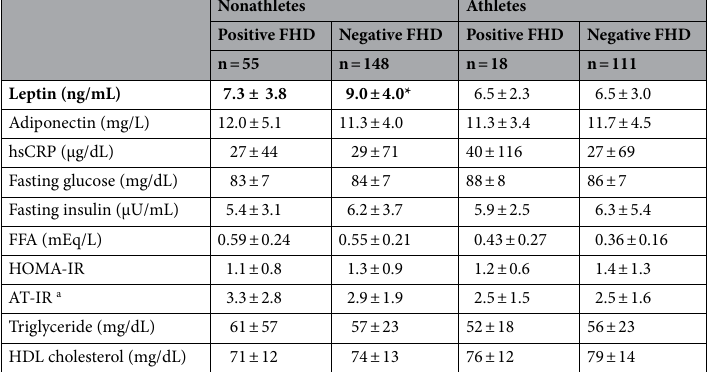
Table 2. Biochemical characteristics of young Japanese women in the presence and absence of family history of type 2 diabetes (FHD). Mean ± SD. a n = 48 and 64 in nonathletes and n = 9 and 32 in athletes with positive and negative family history, respectively. hsCRP: high-sensitivity C-reactive protein, FFA: free fatty acid, HOMA-IR: homeostasis model assessment-insulin resistance, AT-IR: adipose tissue-insulin resistance index. Bold letters indicate * p =